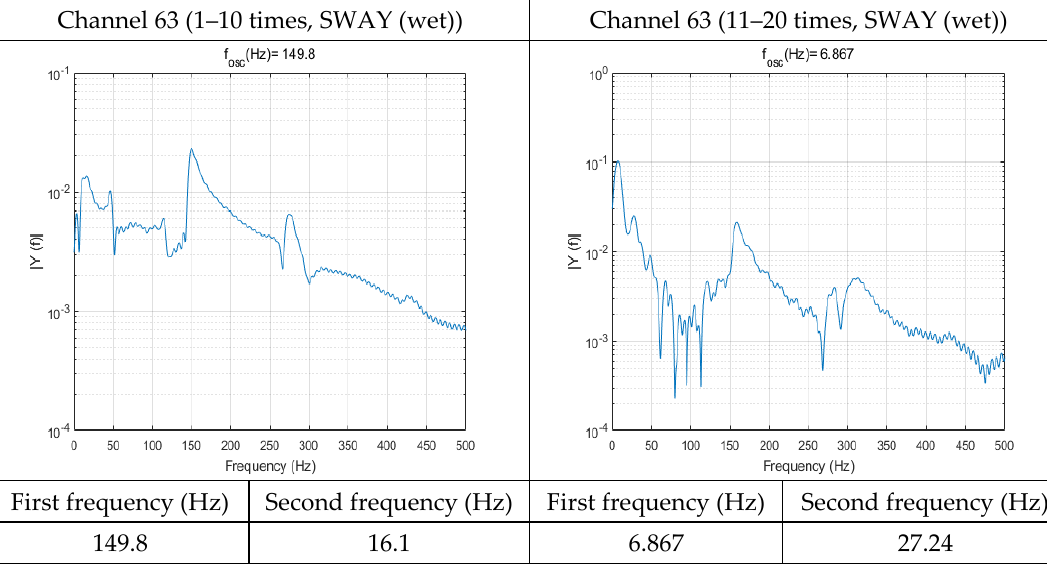
Figure 21. FFT of Channel 63 (Wet Condition, SWAY)